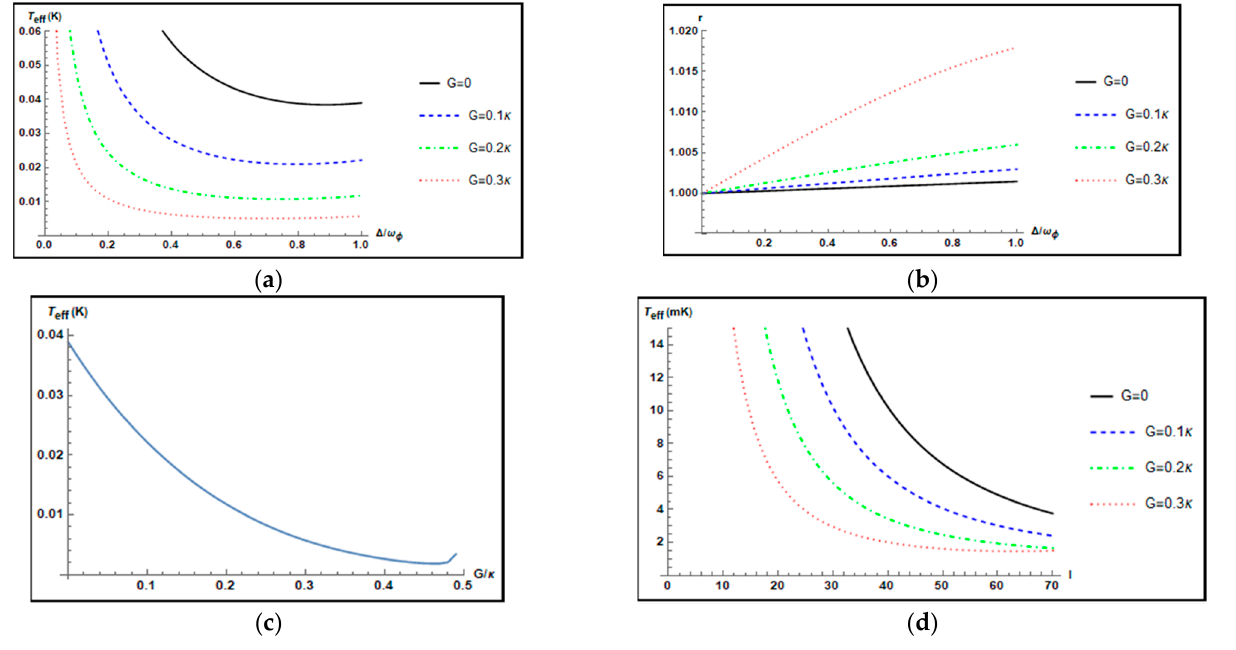
Figure 4. ( a ) Plot of the effective temperature T ef f ( K ) of the mechanical torsional pendulum versus the normalized positive cavity detuning ∆ / ω φ for different parametric gains G = 0, 0.1 κ ,0.2 κ ,0.3 κ , θ = 0, and l = 20. ( b ) Plot of the parameter r versus the normalized positive cavity detuning ∆ / ω φ for different parametric gains G = 0, 0.1 κ ,0.2 κ ,0.3 κ when θ = 0, and l = 20. ( c ) Plot of the effective temperature T ef f ( K ) of the mechanical torsional pendulum versus the parametric gain G of the OPA when ∆ = ω φ , l = 20, and θ = 0. ( d ) Plot of the effective temperature T ef f ( mK ) of the mechanical torsional pendulum versus the orbital angular momentum l carried by the L–G cavity mode for different parametric gains G = 0, 0.1 κ ,0.2 κ ,0.3 κ when ∆ = ω φ and θ =